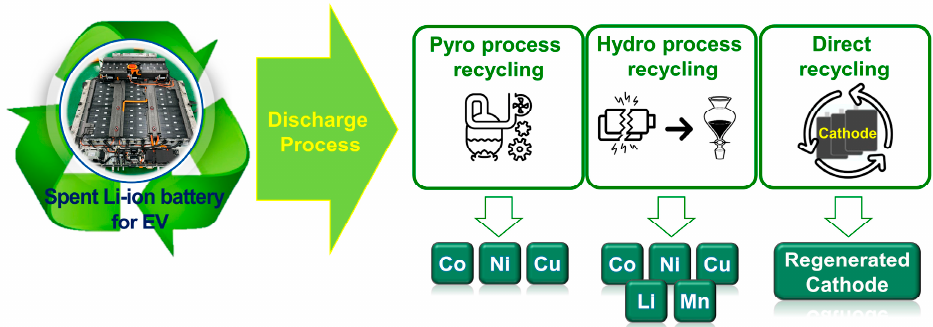
Figure 1. Schematic illustrations describing the three types of recycling methods for spent LIBs: pyrometallurgy process, hydrometallurgy process, and direct recycling.